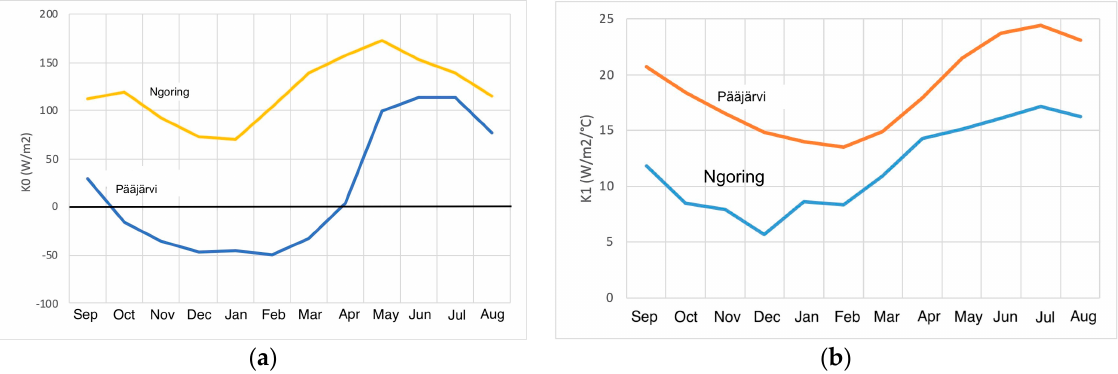
Figure 2. The parameters 𝐾 (cid:2868) (cid:4666)𝐚(cid:4667) and 𝐾 (cid:2869) ( b ) of the linear surface heat transfer formula 𝑄 (cid:2868) = 𝐾 (cid:2868) + 𝐾 (cid:2869) (cid:4666)𝑇 (cid:3028) − 𝑇 (cid:2868) (cid:4667) for Lake Pääjärvi (based on climate data from Jokioinen, 60°49 ′ N 23°30 ′ ° E) and Ngor- ing Lake (34°54 ′ N 97°42 ′